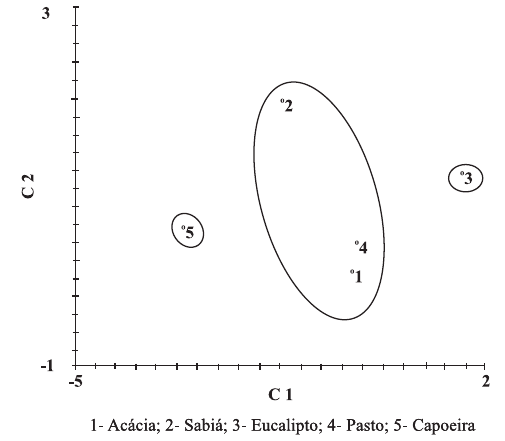
Figura 3. Dispersão gráfica das coberturas vegetais em relação aos dois primeiros componentes prin- cipais, com base no q CO e nas relações CBM/C, 2 NBM/N e C/N microbiana dosolo sob diferentes coberturas